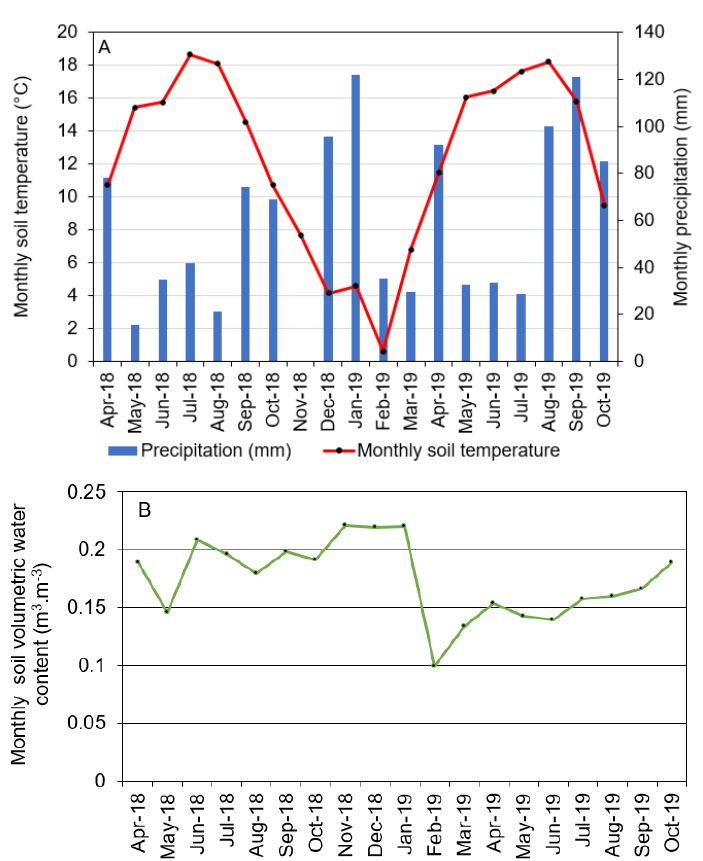
Figure 1. Monthly soil temperature ( ◦ C) and precipitation (A) and monthly volumetric water content (m3.m − 3) (B) from April 2018 to October 2019 in a raspberry field. Soil sensors were installed at a depth of 10 cm in the third replicate of four BDM treatments; data were recorded every 15 min, and the average was calculated for all treatments due to strong similarity. Monthly precipitation was taken from the Washington State University Nooksack AgWeatherNet Station located 8 km east of the study site. Table 2. Environmental data near the commercial raspberry field used in this study in Northwestern WA, USA in 2018 and 2019.